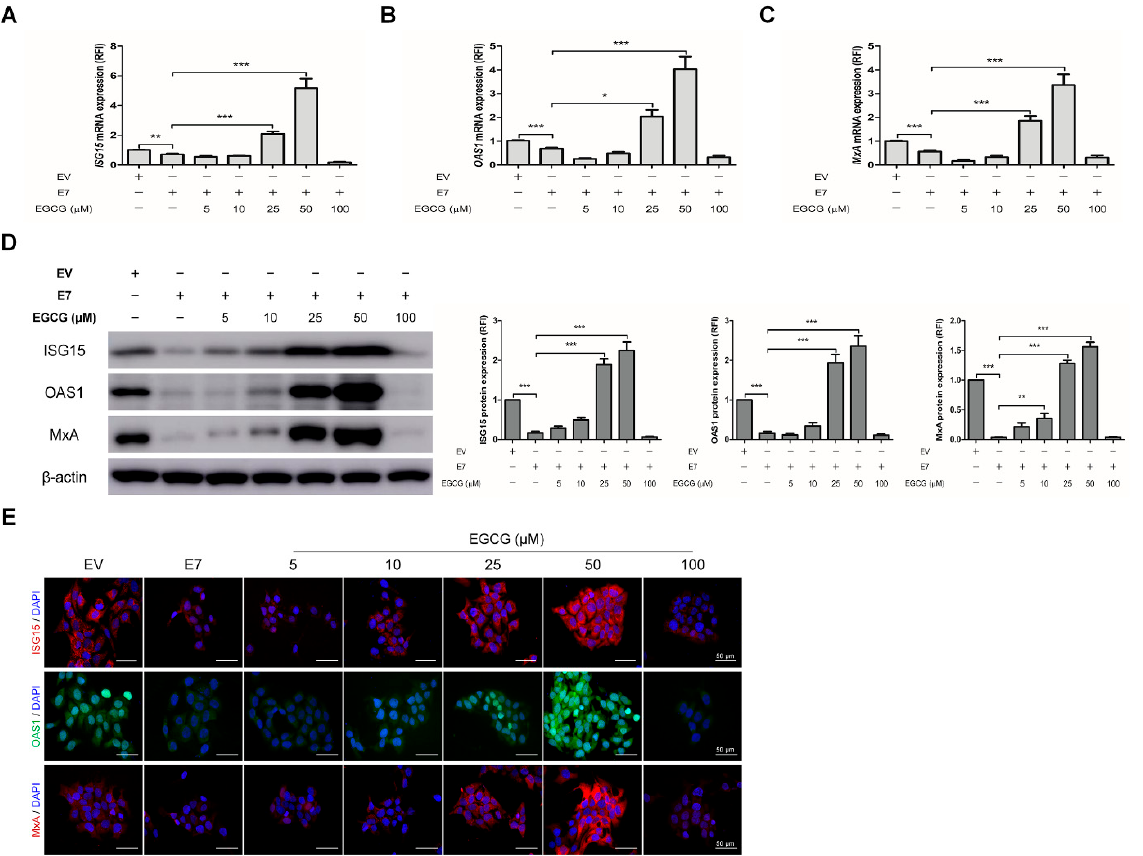
Figure 5. Effect of EGCG pretreatment on the expressions of interferon-stimulated genes in HPV-2 E7 transfected cells. HaCaT cells were pretreated with EGCG at the indicated concentrations for 2 h before transfection, then the pretreated cells were transfected with empty vector or HPV-2 E7 . ( A–C ) Total RNA extracted from cells after 24 h transfection was subjected to the RT-qPCR for the mRNA levels of ISG15 ( A ), OAS1 ( B ), and MxA ( C ). The data are expressed target mRNA levels relative fold to the empty vector. The relative mRNA levels were normalized against levels of GAPDH. ( D ) Cell lysates were collected for western blot to measure the ISG15, OAS1, and MxA expressions in cells pretreated with EGCG. The graph indicates quantitative representation of the protein levels of ISG15, OAS1, and MxA obtained from a densitometric analysis. β -actin served as a loading control for protein normalization. The results are expressed as the mean ± SEM of three independent experiments. * p < 0.05, ** p < 0.01, *** p < 0.001 compared with empty vector or E7 . ( E ) Representatively image of immunofluorescent staining of ISG15 and MxA (red), OAS1 (green) in pretreated cell with EGCG. DAPI (blue) was used to counterstain nuclei. Images by fluorescent microscope with 400× magnification, scale bars = 50 μ m.